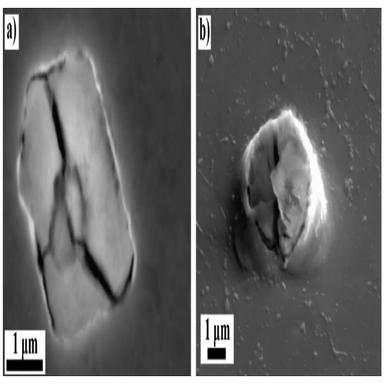
AsB micrographs of spheroidal inclusions in (a) the parent material of the LKW Eurofer 97 and (b) a non-welded sample of Eurofer 97 used for a transient thermal ageing study.